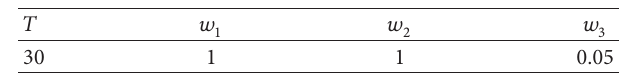
Table 2: Parameters of fitness function.